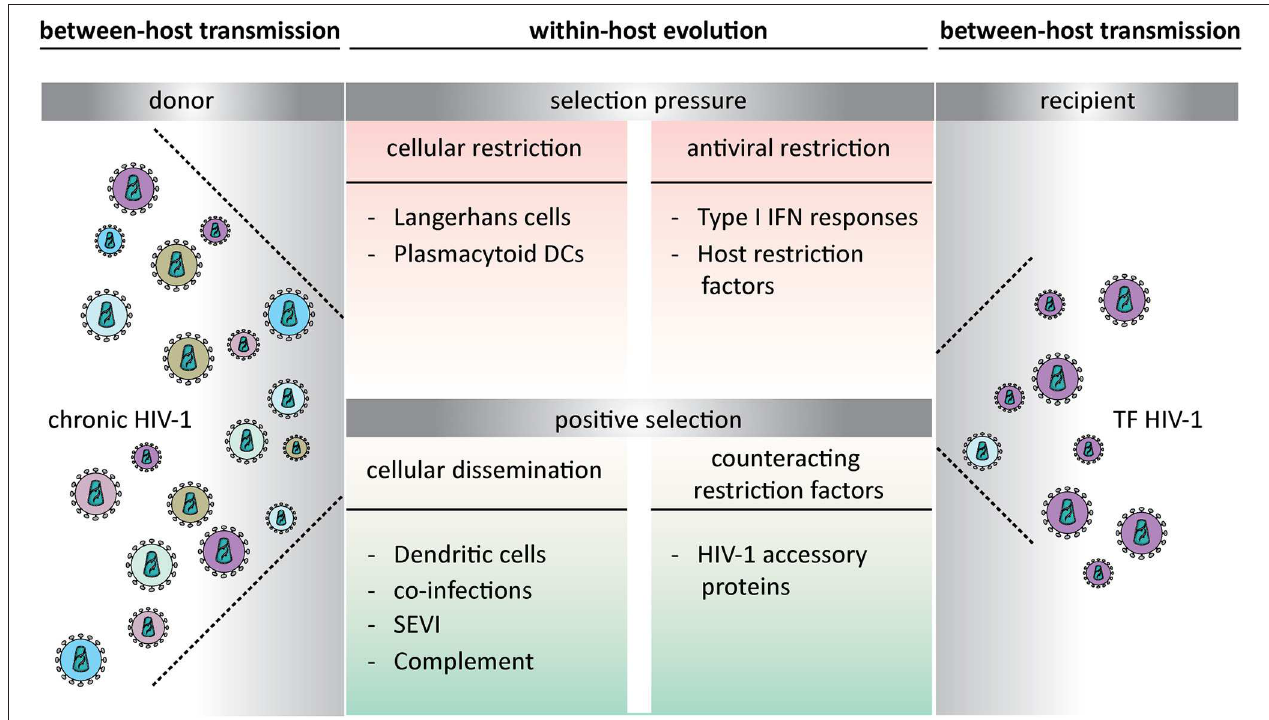
FIGURE 1 | Opposing selection pressures during transmitted founder HIV-1 transmission at mucosal surfaces. The within-host evolution creates a selection bias that leads to either viral restriction or establishes a new infection. Transmitted founder viruses are able to escape host restriction and are therefore responsible for establishing productive infection. TF HIV-1, transmitted founder HIV-1; DCs, dendritic cells; IFN, Interferon; SEVI, semen-derived enhancer of virus